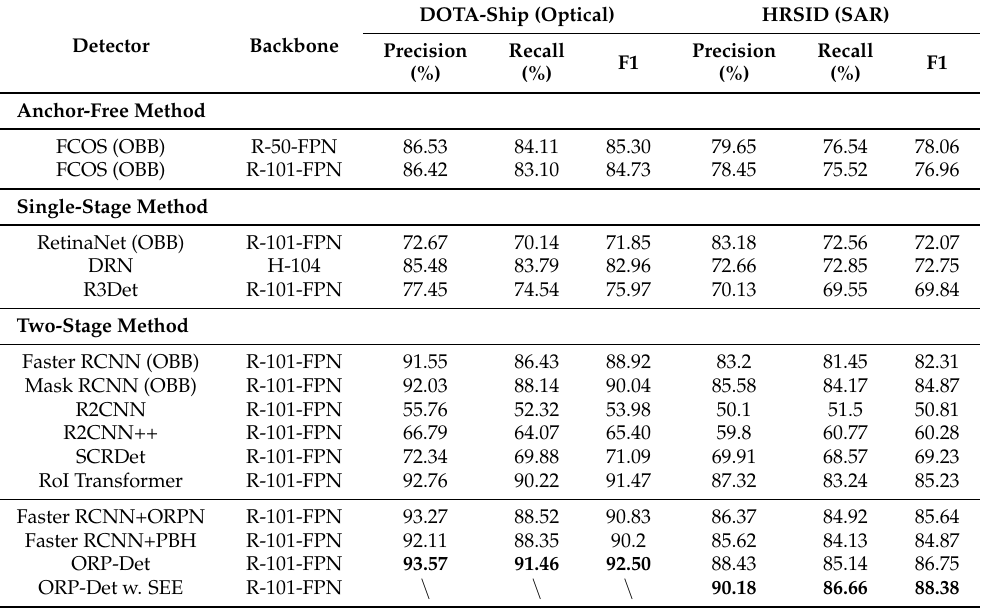
Table 6. Experimental results of the overall framework on HRSID and DOTA-Ship